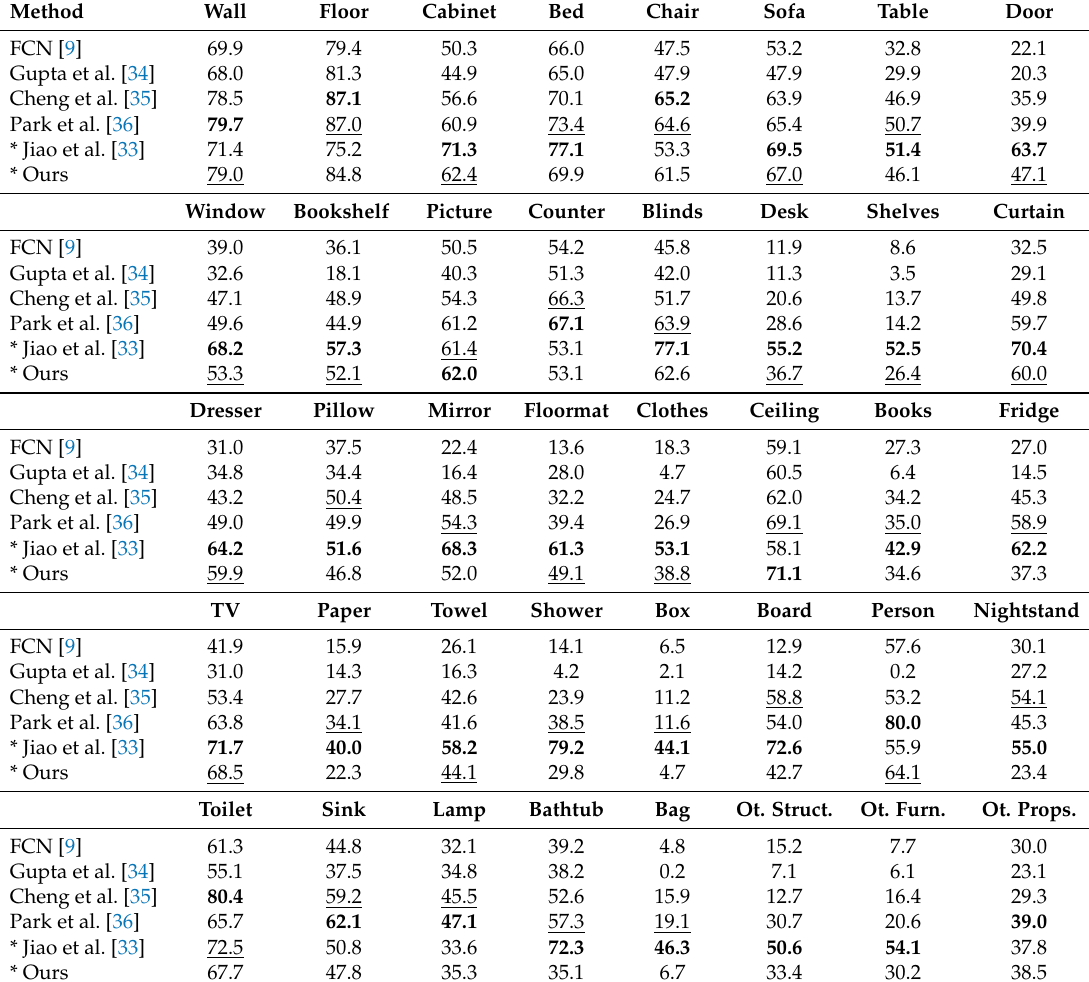
Table 3. Comparison of IoU with previous approaches on each category of the NYU Depth v2 dataset. * takes an RGB image as an input whereas the others take an RGB-D image. The bold and underlined items represent the best and second place, respectively.